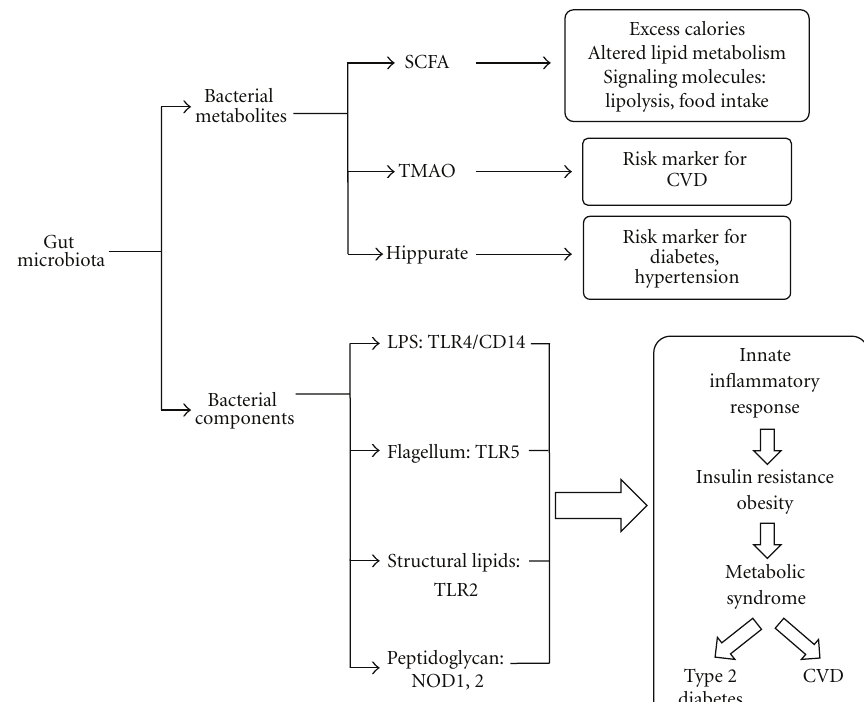
Figure 2: Gut microbiota can have an e ff ect on the host’s health via bacterial metabolites, that is, SCFA and TMAO, and immune responses to bacterial components, that is, TLR4 sensing of LPS. In general, bacterial metabolites have varied e ff ects on metabolism and are markers of risk for disease, whereas bacterial components cause an innate inflammatory response resulting in insulin resistance leading to metabolic syndrome, type 2 diabetes, and